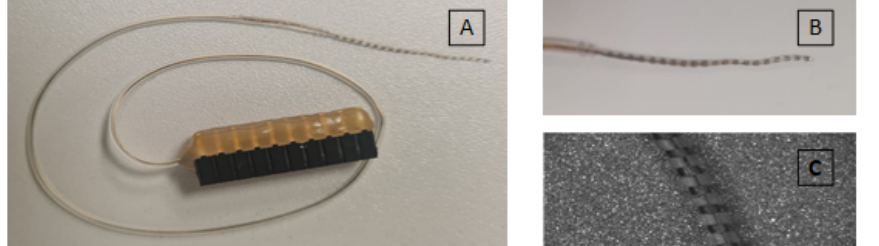
Figure 1. ( A ) Electrode array with associated wiring (wraped in silicon carrier) soldered and glued to a female connector, ( B ) close-up version of 20 electrode contacts, ( C ) part of electrode array under